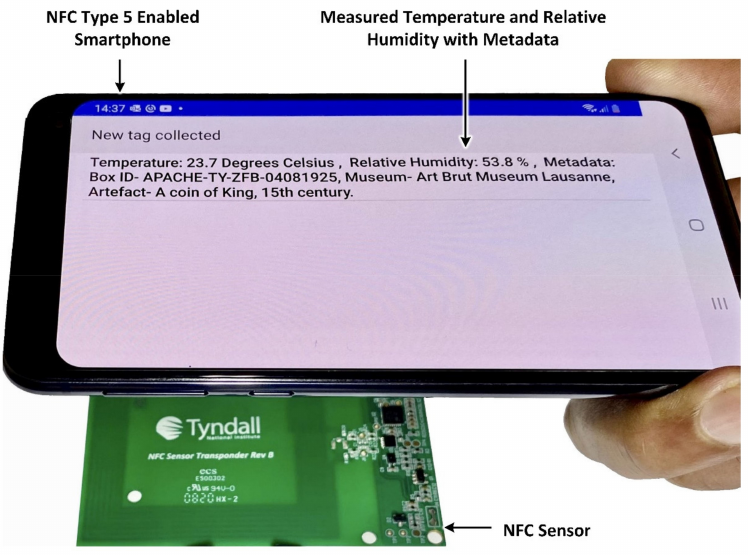
Figure 4. Demonstration of wirelessly powered (battery-less) NFC sensor using